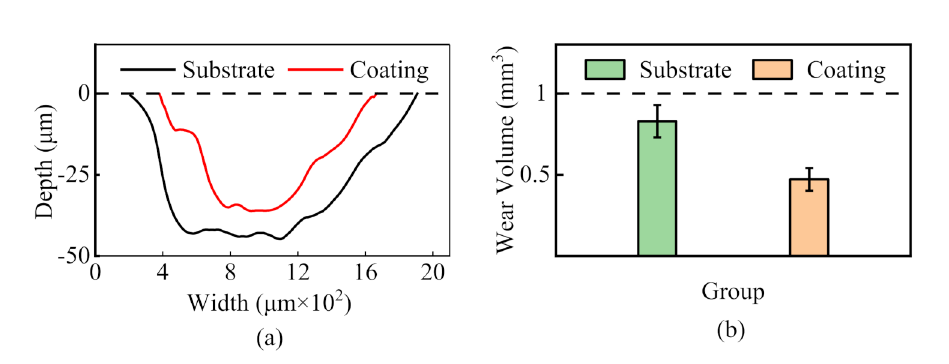
Figure 15. The wear contour curves ( a ) and wear volume ( b ) of Ti6Al4V alloy and